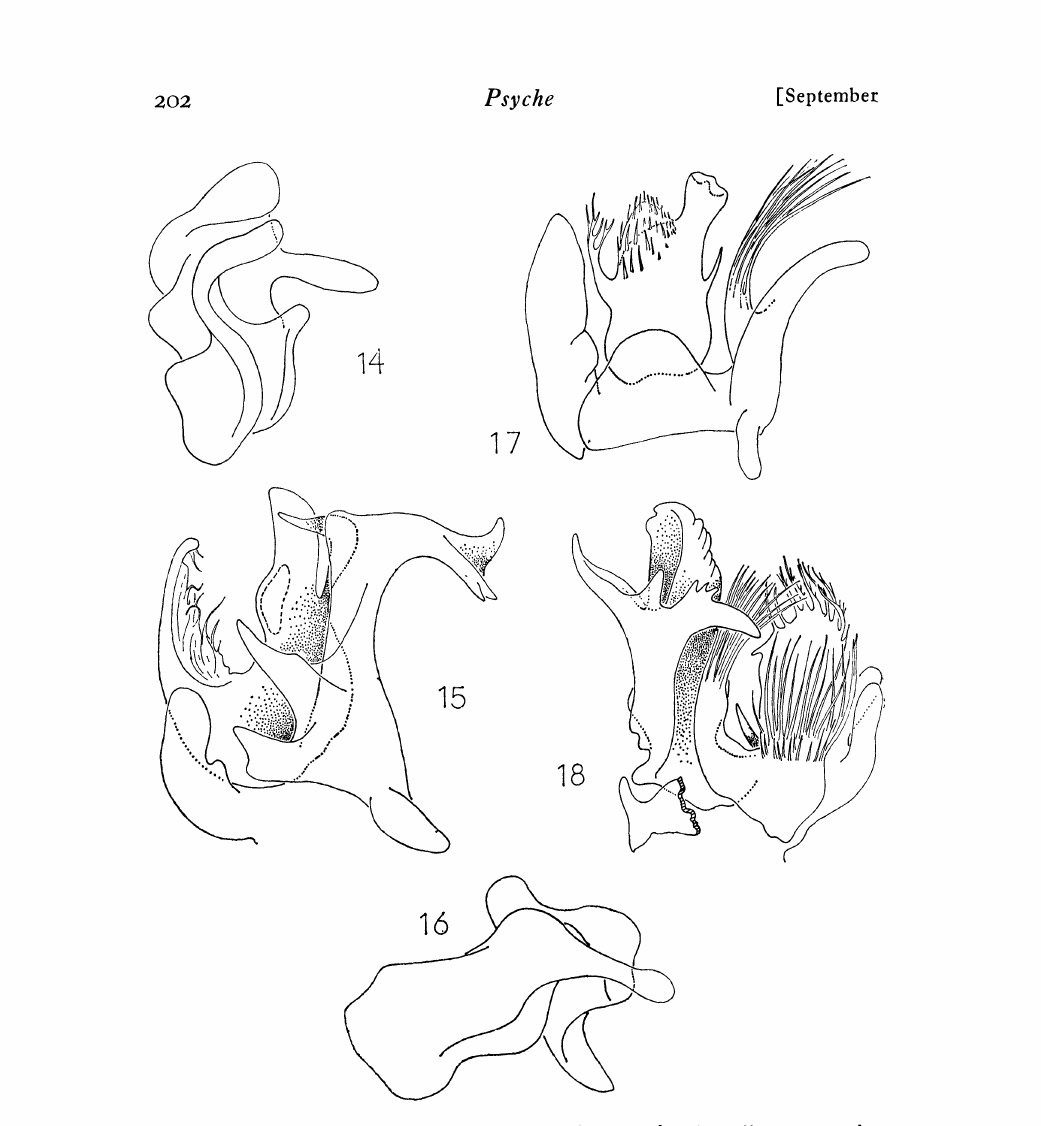
Fig. 14. Left posterior gonopod of Rhiscosomides benedictae, anterior view. Figs. 15, 16. R. malcolmi. Fig. 15. Right anterior gonopod, lateral view. Fig. 16. Left posterior gonopod, anterior view. Fig. 17. Right anterior gonopod of R. acoescor, lateral view. Fig. 18. Right anterior- gonopod of R. trinitarium, mesal